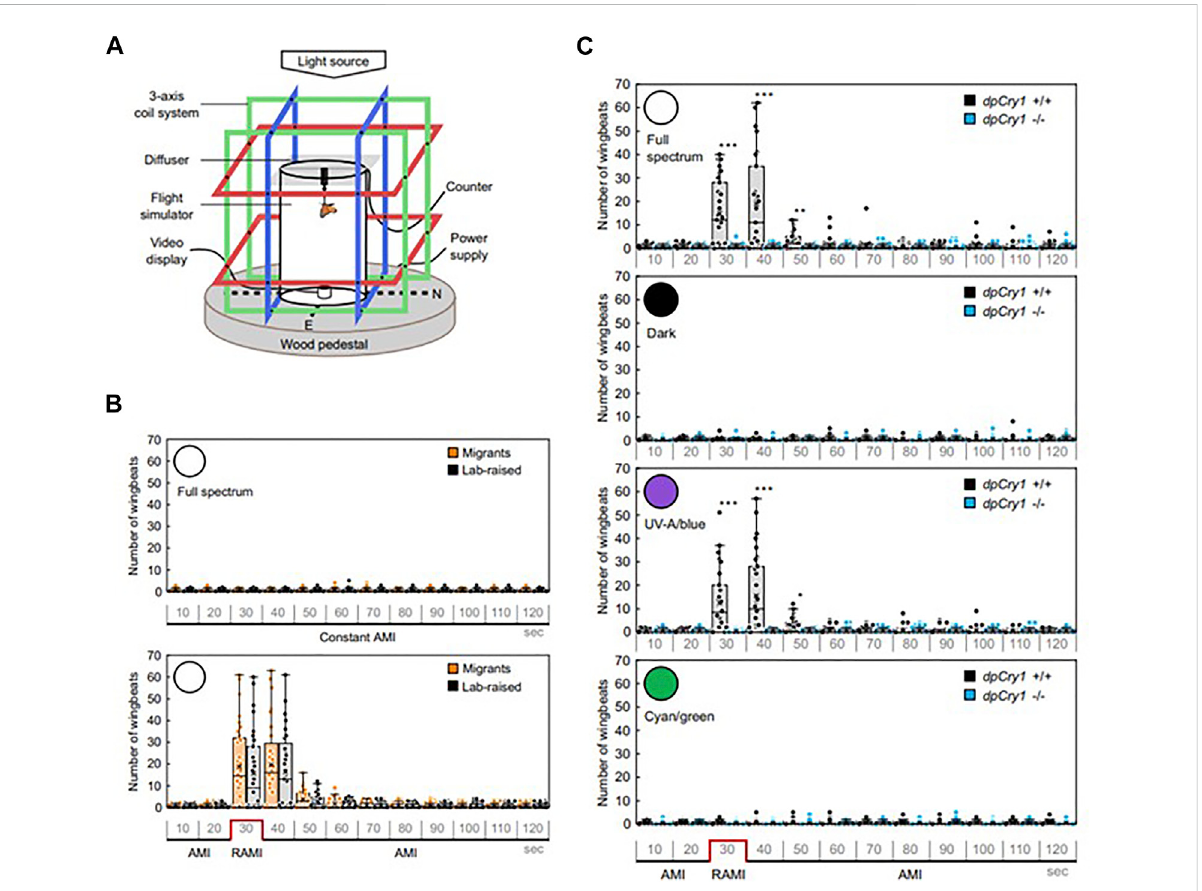
FIGURE 4 Magnetic fi eldeffectsonMonarchbutter fl ybehaviour. (A) FlightsimulatorwiththreedifferentaxesofHelmholzcoilswithaMonarchtetheredin the middle of the arena. (B) Migrant and lab-reared Monarchs do not respond to a constant ambient MF (~45 μ T AMI, top panel) unless it is reversed (RAMI, bottom panel), when they immediately increase their wingbeats in response in full spectrum light. (C) The wingbeat response to RAMI is observedunderfullspectrumlightbutnotindarknessinwild-typeof DpCry1 − / − knockoutMonarchs.Neitherdoes DpCry1 − / − showtheresponse in blue/UV light in contrast to the wild-type. Neither wild-type nor the mutant respond to RAMI under cyan/green light (480 – 580 nm) (Figure redrawn from Figures 1, 2 of Wan et al., 2021 under CC open access (http://creativecommons.org/publicdomain/zero/1.0/). See article for description of